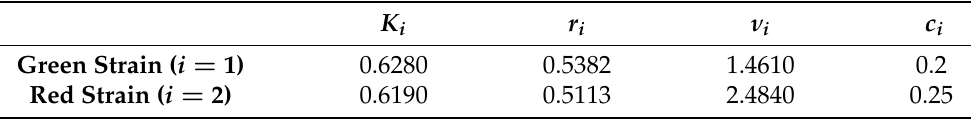
Table 3. Parameters for the Baranyi–Roberts system after performing the optimization procedure. Note that we have only determined the growth parameters r 1 and r 2 , while the others have been taken from [28] (Experiment